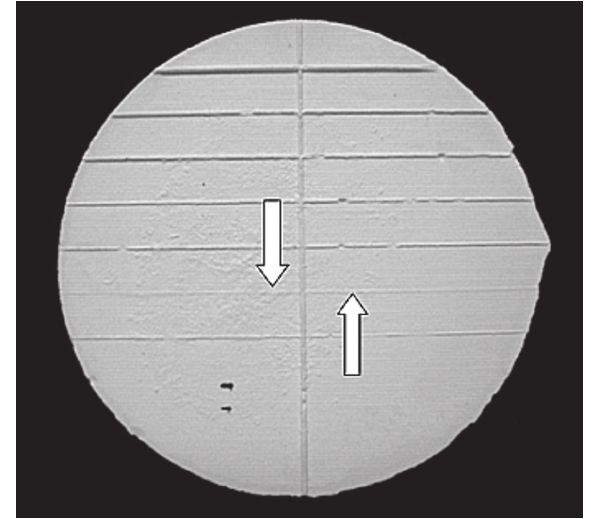
Figure 3- Graphic with the results of the